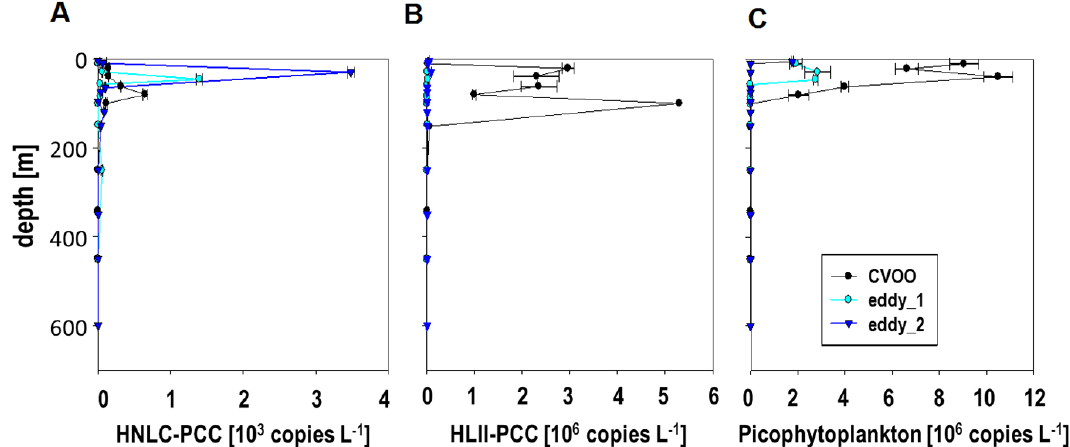
Figure 8. Vertical distribution of Prochlorococcus and Synechococcus ecotypes quantified by qPCR. While the HNLC-PCC (a) dominates the eddy water mass and increases from the first observation (eddy_1) to the second observation (eddy_2) it is nearly absent outside the eddy (CVOO). HLII-PCC (b) occurs in highest abundances outside the eddy, while being close to the detection limit inside the eddy. (c) shows the distribution of pico-phytoplankton as detected with a general primer-probe system (Suzuki et al.,